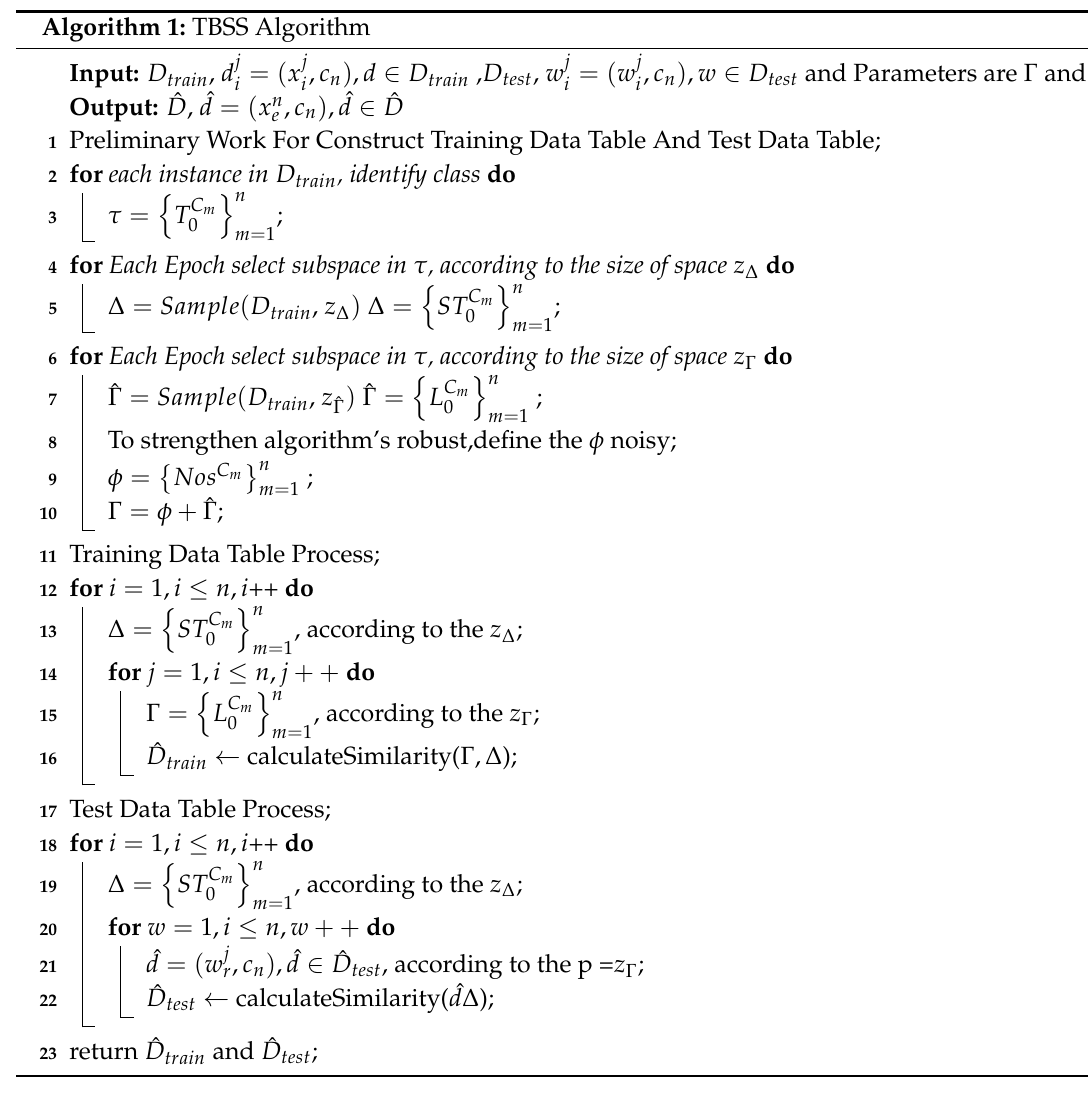
Figure 3. Process of transferring raw test dataset to new test